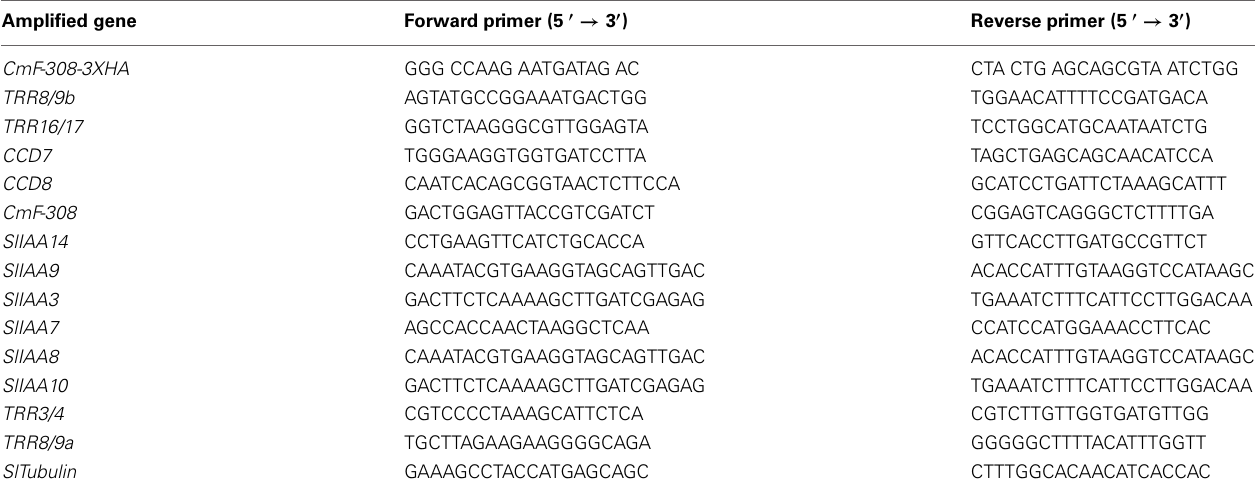
Table A1 | List of primers used for amplification of the examined genes. Amplified